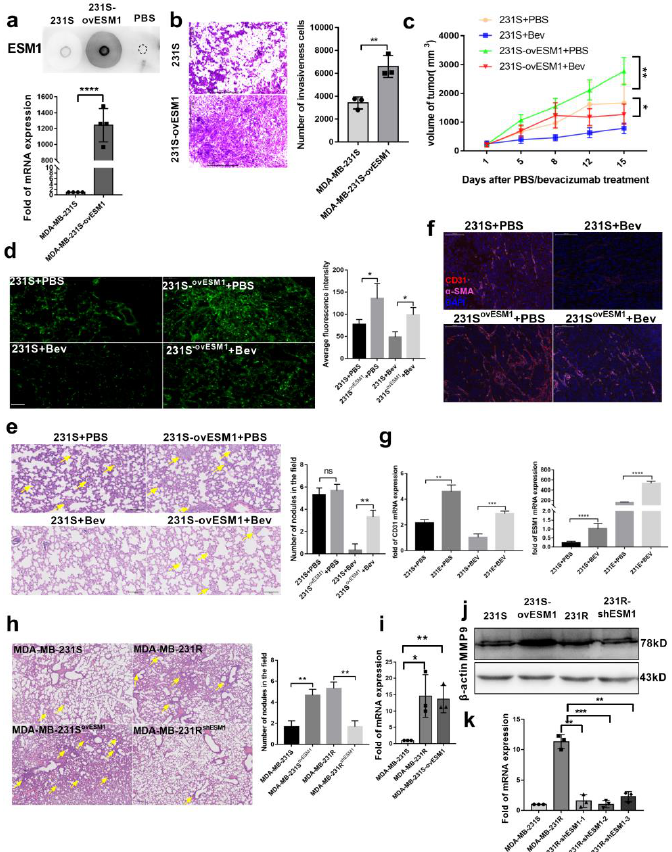
Figure 3. ESM1 promoted bevacizumab-resistance tumor metastasis. ( a ) Dot blotting and qRT-PCR of ESM1 levels in MDA-MB-231-S tumor cells with or without overexpressed ESM1. **** p < 0.0001, by t test. ( b ) Representative transwell invasion images of MDA-MB-231-S and MDA-MB-231-S ovESM1 cells, ** p < 0.01; n = 3/group. Scale bar, 200 µ m. ( c ) Tumor growth volume over time following subcutaneous transplant of MDA-MB-231-S or MDA-MB-231-S ovESM1 tumor tissues into nude balb mice. n = 5 for each condition. * p < 0.05; ** p < 0.01 by two-way ANOVA test. Error bars represent SD. ( d ) Representative images and statistical analysis of MDA-MB-231-S or MDA-MB-231-S ovESM1 lung micro-metastasis treated with PBS or bevacizumab. Scale bar, 100 µ m, * p < 0.05 by t test. ( e ) Representative images and statistical analysis of MDA-MB-231-S or MDA-MB-231-S ovESM1 lung macro-metastasis treated with PBS or bevacizumab. Scale bar, 100 µ m, ** p < 0.01 by t test. ( f ) Representative images of MDA-MB-231-S or MDA-MB-231-S ovESM1 tumor sections from mice treated with PBS or bevacizumab. CD31 was co-stained with α -SMA and nucleus. Scale bar, 50 µ m. ( g ) qRT-PCR of CD31 and ESM1 mRNA levels in MDA-MB-231-S and MDA-MB-231-S ovESM1 t test. ( h ) Representative images and statistical analysis of HE staining to assess the number of lung metastasis in the different treatment groups; scale, 100 µ m, ** p < 0.01 by t test. ( i ) qRT-PCR of MMP9 mRNA levels in MDA-MB-231-S, MDA-MB-231-R, MDA-MB-231-S ovESM1 cells. n = 3/group. * p < 0.05; ** p < 0.01, by t test. ( j , k ) Western blot and qRT-PCR analysis MMP9 in MDA-MB-231-S, MDA-MB-231-R, MDA-MB-231-S ovESM1 and MDA-MB-231-R shESM1 cells. ** p < 0.01; *** p < 0.001, by t test (Figure